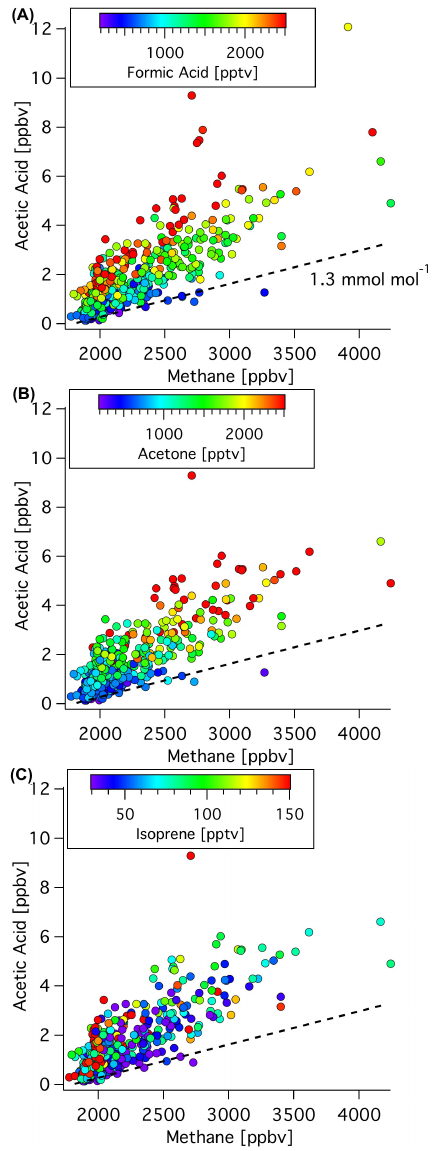
Figure 8: Acetic acid vs. methane shown with the inferred acetic acid:methane emission ratio from dairy operations. Acetic acid exceedances above the emission ratio are due to other sources of acetic acid coincident with emissions of (A) formic acid, (B) acetone, and (C) isoprene.